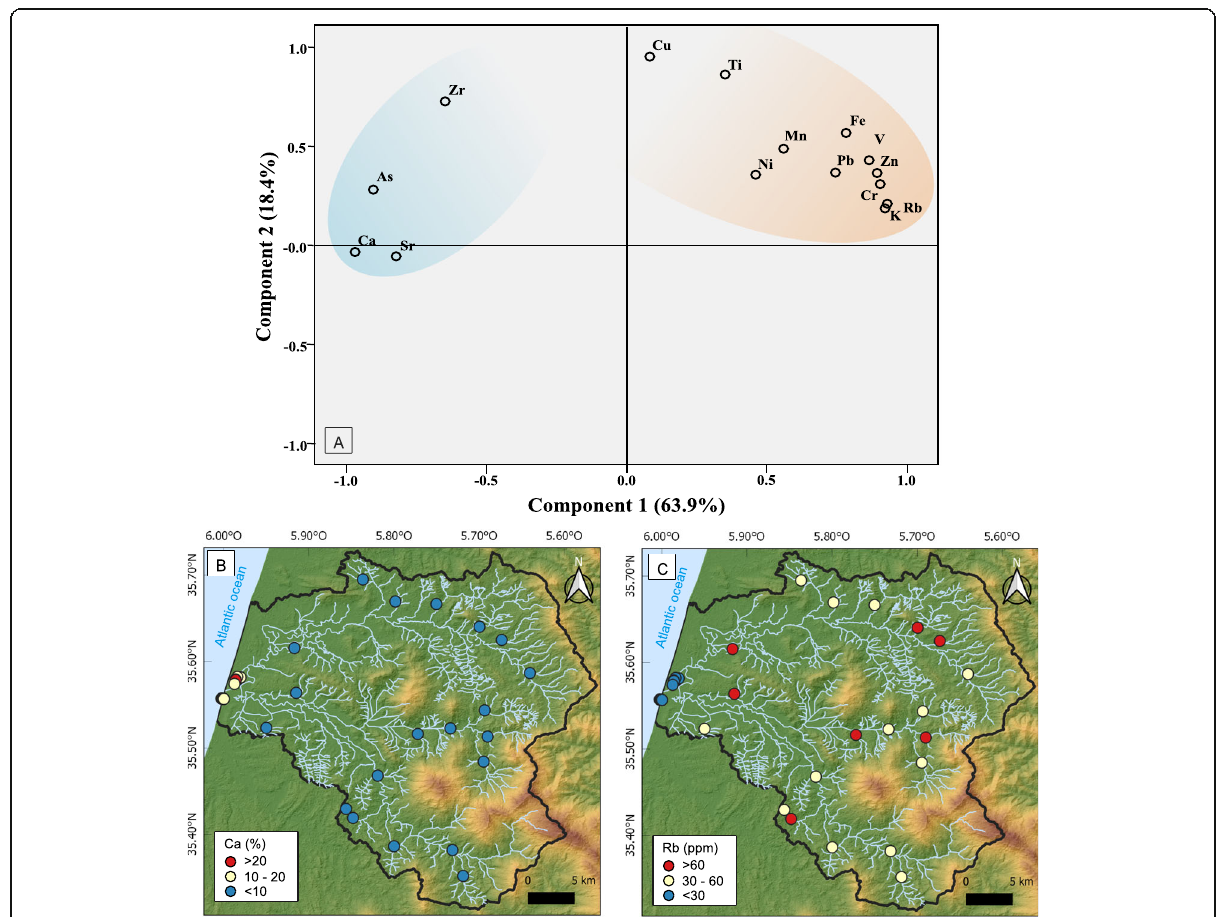
Fig. 2 a Principal Component Analysis of geochemical data from coastal and watershed surface samples. b , c Maps of Calcium and Rubidium contents around the Tahaddart